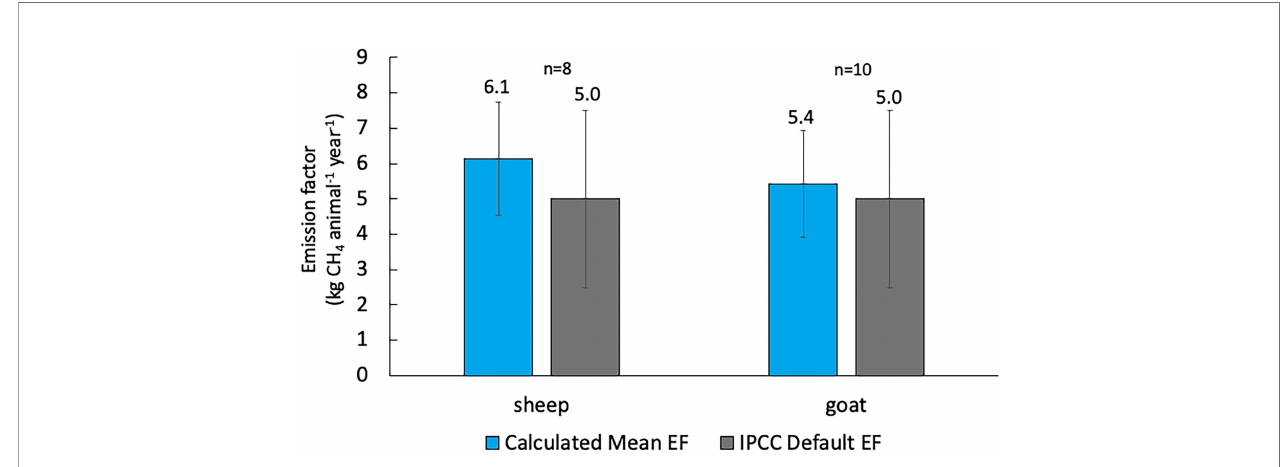
FIGURE 3 | Mean of enteric CH 4 emission factors (EFs) for small ruminants (sheep and goats) in sub-Saharan Africa compared to IPCC defaults EFs (EFs for small ruminants did not change between 2006 and 2019). Error bars for calculated mean EFs are expressed as ± 95% CI, whereas errors bars for IPCC default EFs express default uncertainty as a percent (50%). n = number of observations for each